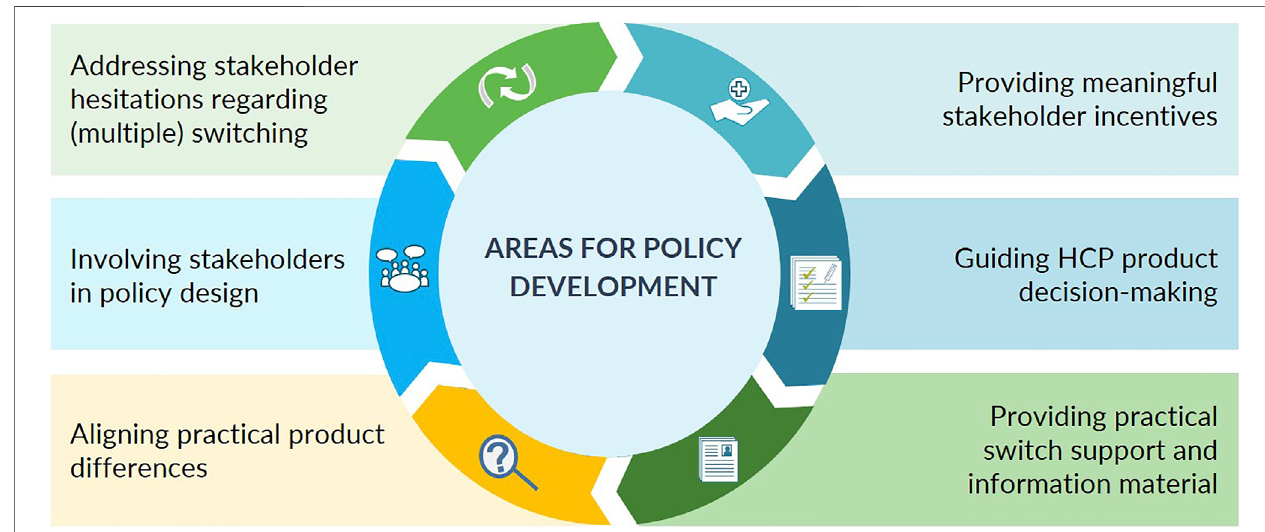
FIGURE 2 | Biosimilar use and switching in Belgium — 6 main healthcare professional-identi fi ed areas for policy development.